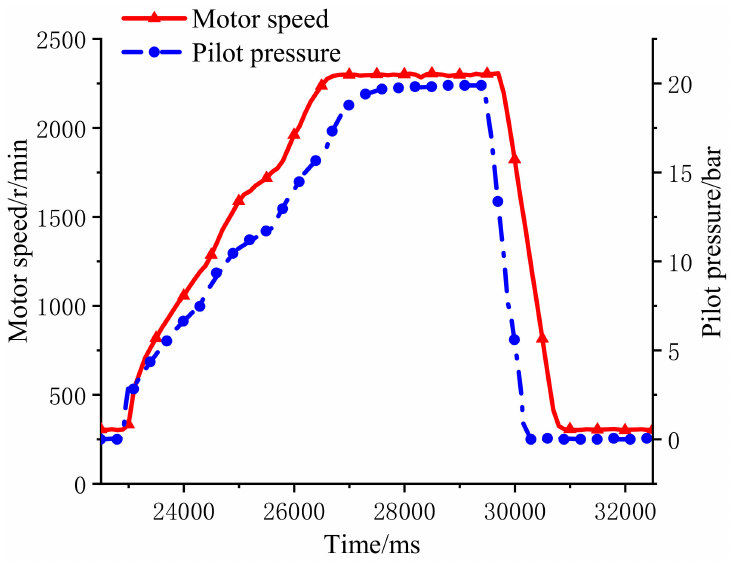
Figure 20. Ramp response curve of the electric motor speed with pilot